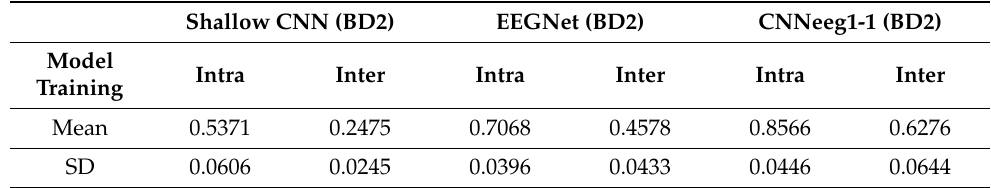
Table 5. Average accuracy of the reference algorithms Shallow CNN, EEGNet, and the new CNNeeg1- 1 algorithm in imagined vowel classification tasks for intra-subject and inter-subject training using BD2